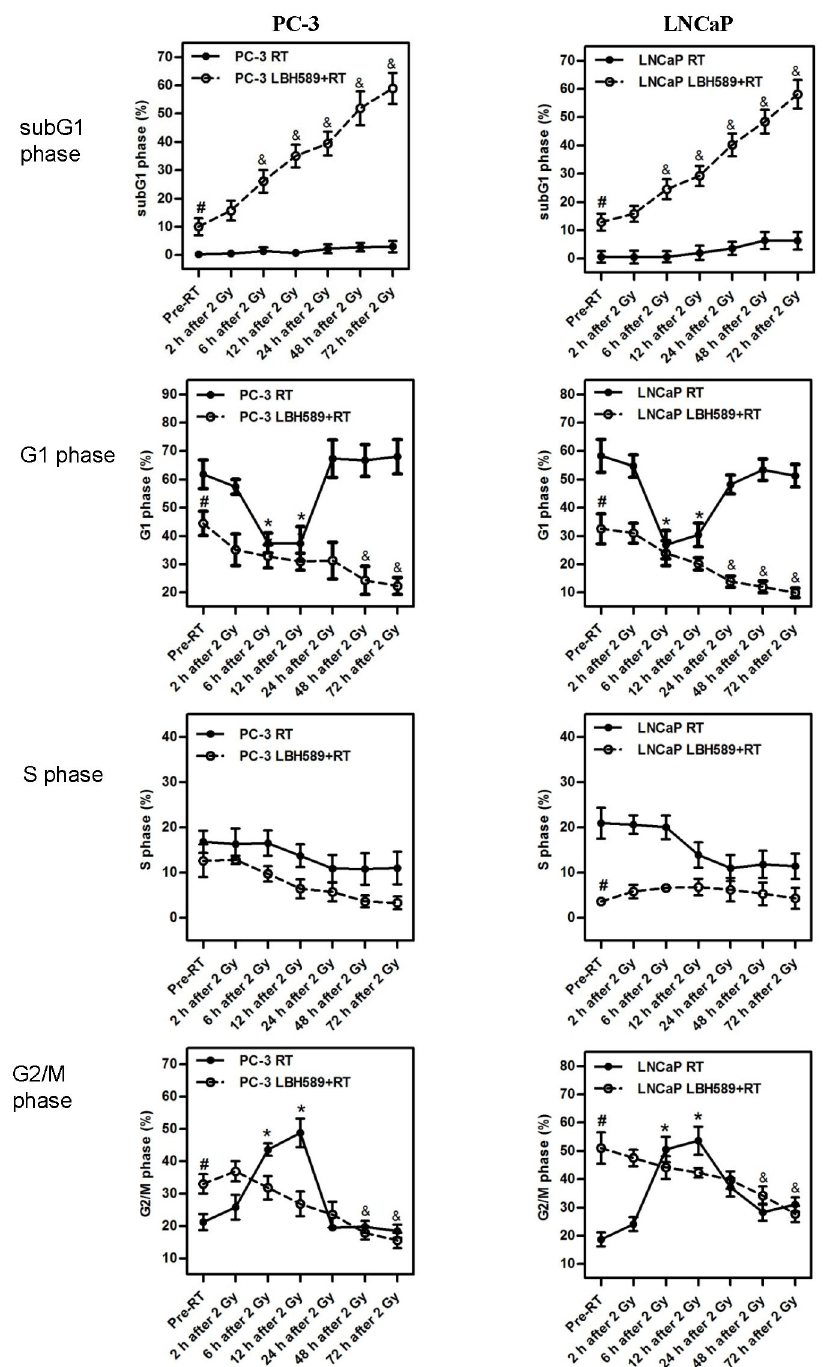
Figure 2. Effects of RT or combination treatment (LBH589 and RT) on cell cycle arrest in PC-3 and LNCaP CaP cell lines. The percentage of subs G1, G1, S, and G2/M populations were analysed using flow cytometry from pre-RT to 72 h post-RT; p <0.01(*): significant difference in the percentage of cell cycle phase between the indicated time point and the “Pre-RT” time point in RT groups; p <0.01( # ): significant difference in the percentage of cell cycle phase between the RT group and the combination group at the “Pre-RT” time point; p < 0.01( & ): significant difference in the percentage of cell cycle phase between the indicated time point and the “Pre-RT” time point in combination group. All results were from three independent experiments (N=3). Points, mean; bars, SD.